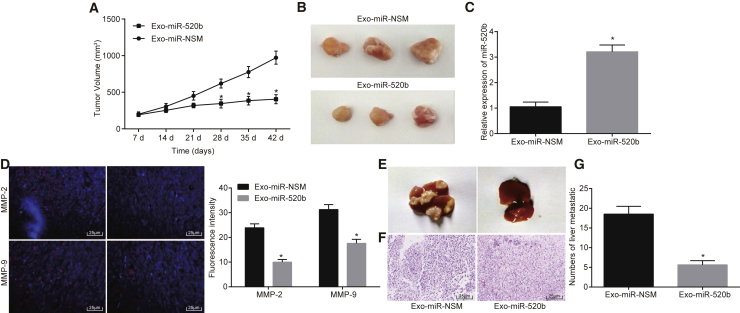
Exosomal miR-520 Overexpression Inhibits Tumor Growth and Metastasis(A) The tumor volume of the PC tumor was inhibited after treatment with the exosomic miR-520b mimic. (B) Representative images of tumors formed in nude mice. (C) Detection of miR-520 expression by qRT-PCR. (D) Expression of invasive markers (MMP-2 and MMP-9) detected by immunofluorescence assay (×400). (E) Pictures of hepatic lymph node metastasis of nude mice after an 8-week injection with the transfected PC cell line SW1990 through the caudal vein (F) Liver morphology of nude mice after an 8-week injection with the transfected PC cell line SW1990 through the caudal vein. (G) The number of lymph metastatic nodes in nude mouse livers counted by H&E staining after injection with transfected PC cell line SW1990 for 8 weeks. *p < 0.05 versus the Exo-miR-NSM group. Data in the figure were measurement data, which were expressed as mean ± standard deviation and compared by independent-sample t test, n = 12.